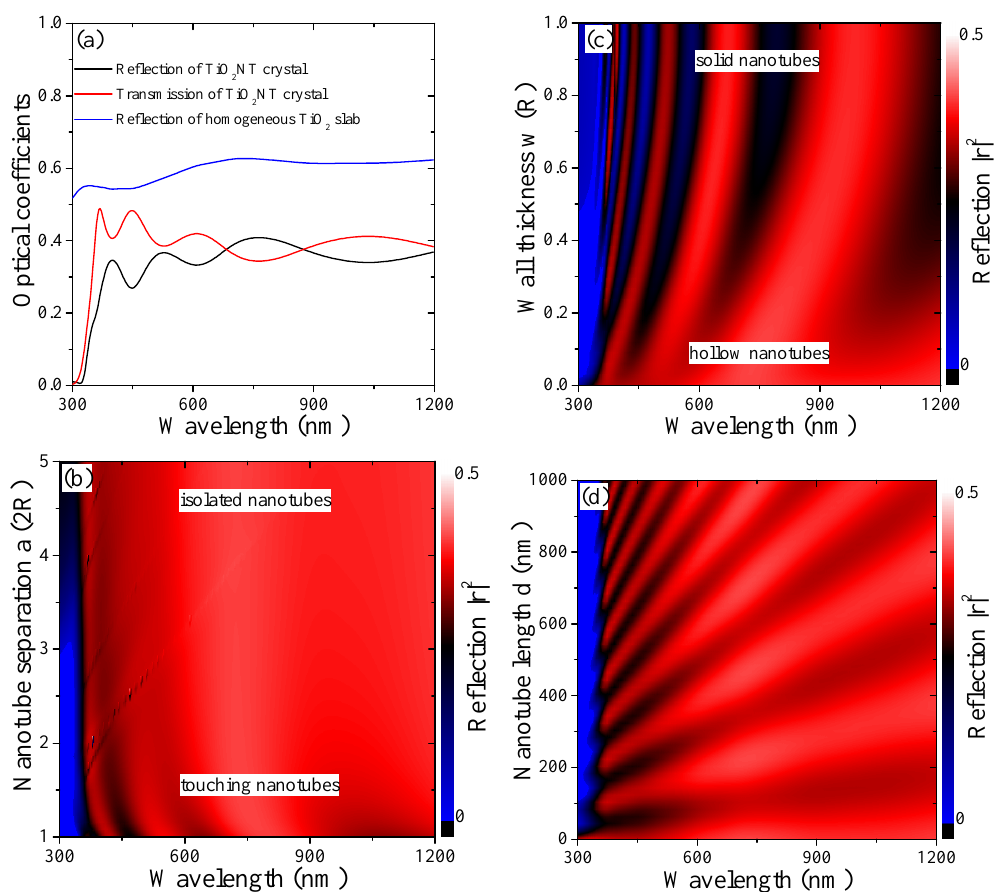
Figure 3. ( a ) Optical spectra of a TiO 2 nanotube pillar array with d = 500 nm, a = 160 nm, R = 70 nm and w = 10 nm comparing to the reflection of a homogeneous TiO 2 slab of the same thickness. Studying the reduction in surface reflection for spectra of TiO 2 NT arrays as a function of ( b ) nanotube wall thickness w ∈ { 0 + . . . R } , ( c ) lattice parameter a ∈ { 2 R . . . 10 R } , and ( d ) nanotube length d ∈ { 0 . . . 1000 }